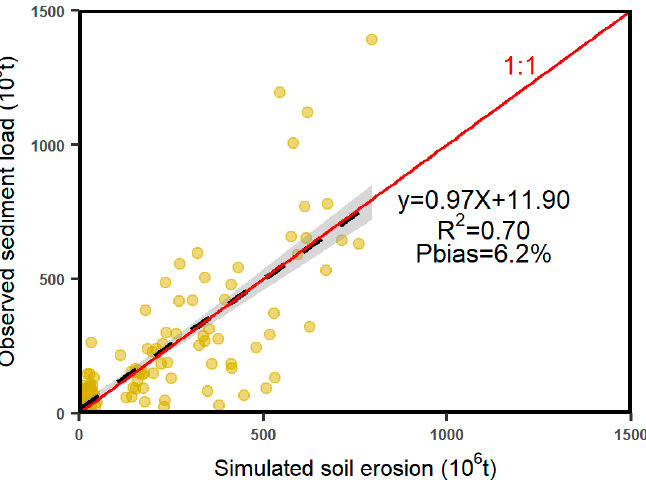
Figure 9. Comparison of simulated soil erosion and observed sediment load in five controlled wa- tersheds and the Hetong Region. watersheds and the Hetong